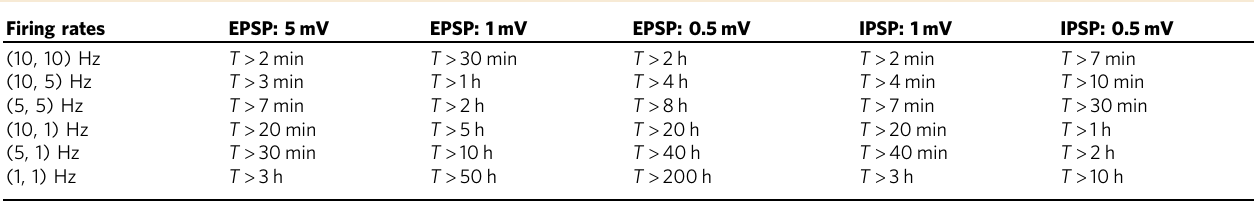
connections that were not detected. Points lying on the nonzero y -axis are the functional or virtual connections that were esti- mated for unconnected pairs. The points in the fi rst and third quadrants represent true positives, or existing connections whose signs were correctly inferred as excitatory or inhibitory, respec- tively. The points in the second and fourth quadrants are existing connections whose signs were misclassi fi ed.